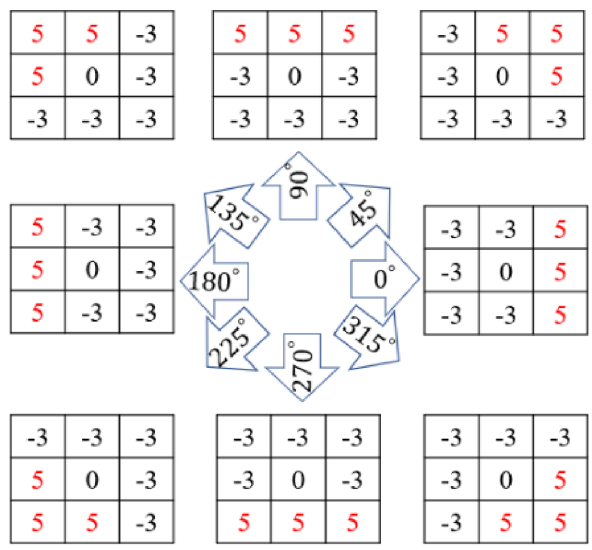
Fig. 1 Non-linear Kirsch kernels in 8 rotations [37]